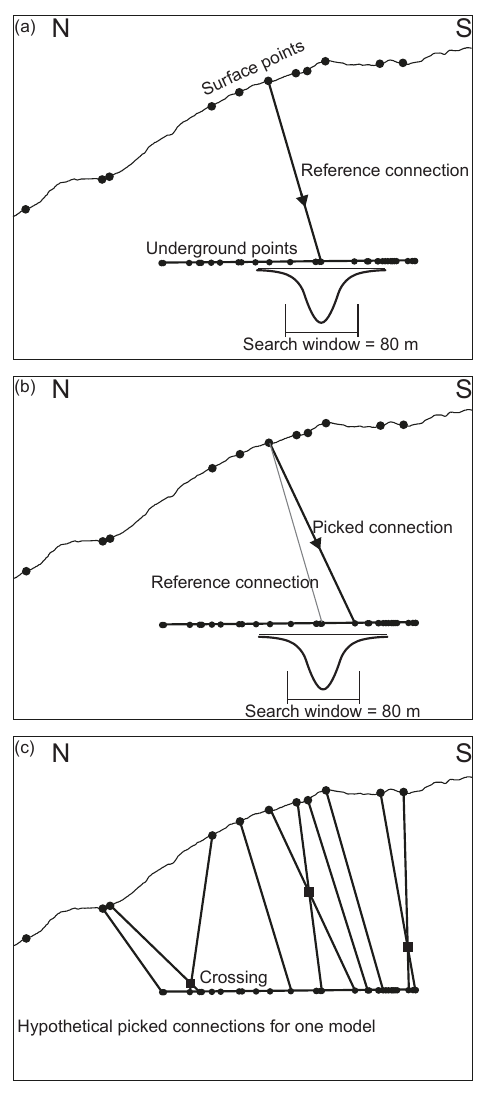
Figure 5. Schematic cross section illustrating the statistical mod- elling methodology for one example. (a) Reference state is defined by aforementioned workflow. A search window of 80m is assigned to the reference underground point. (b) The code picks a possible underground point within the 80m search window based on a nor- mal Gaussian distribution and calculates the connection. (c) For ev- ery surface point one underground point is picked and connected by a projection line (hypothetical fault plane). By connecting each surface point with one underground point, a connection pattern is formed. Ten thousand runs were performed, each connecting differ- ent surface and underground points. The 10000 connection patterns are compared with each other and evaluated by a penalty criterion. This penalty criterion addresses the number of crossings and rate solutions with a lowest and highest number of fault plane crossings, yielding a probability for connecting a specific surface point to a certain underground